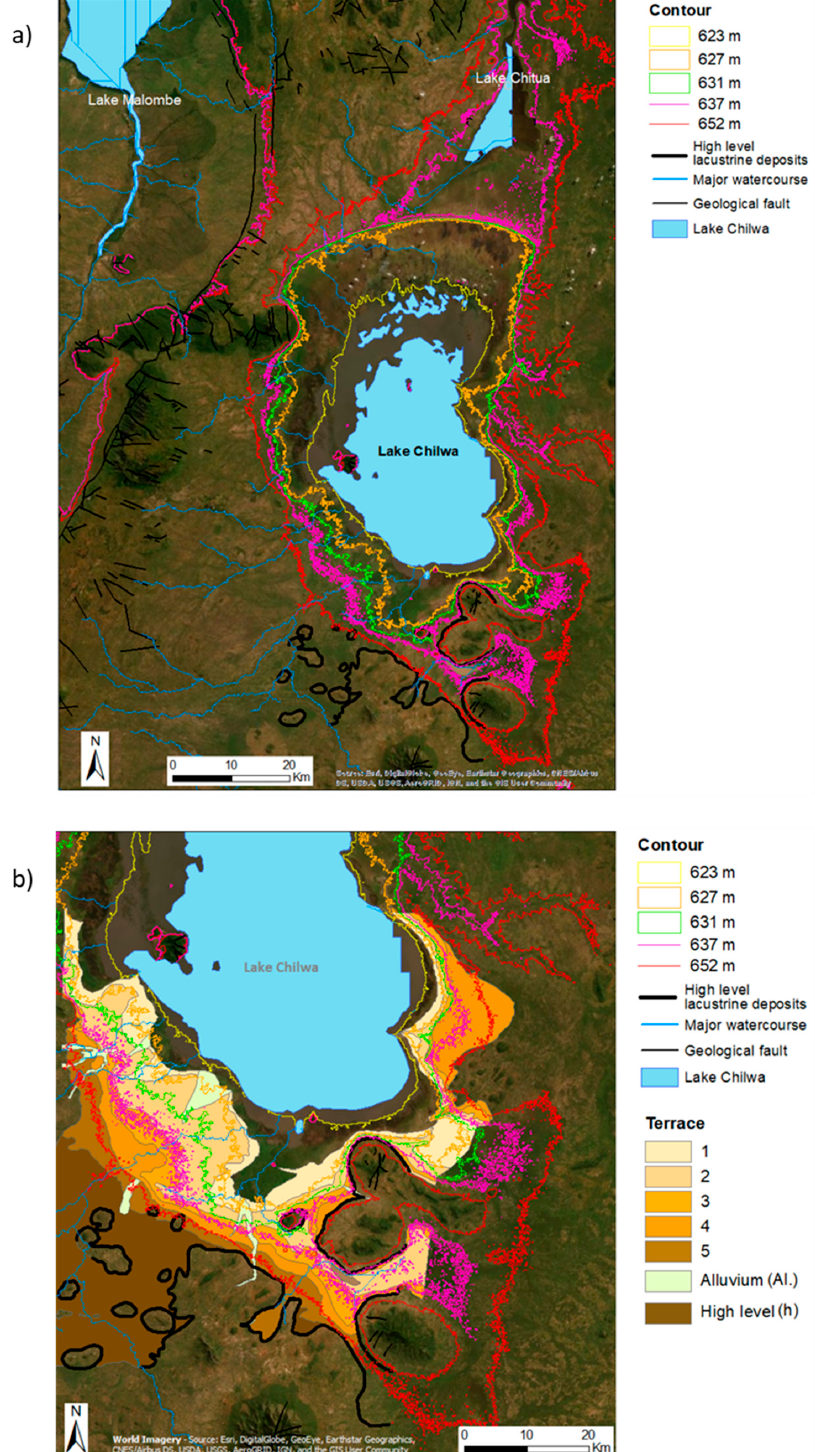
Figure 3. Estimated former Lake Chilwa extent based on relict shoreline elevations contoured over current ground surface shown against a backdrop of High Level and Lake Terrace deposits (locations of these deposits are based on Garson and Walshaw [31]) for: ( a ) Lake Chilwa Basin area; ( b ) close-up of Phalombe District and surroundings. Data are shown over a satellite image backdrop.